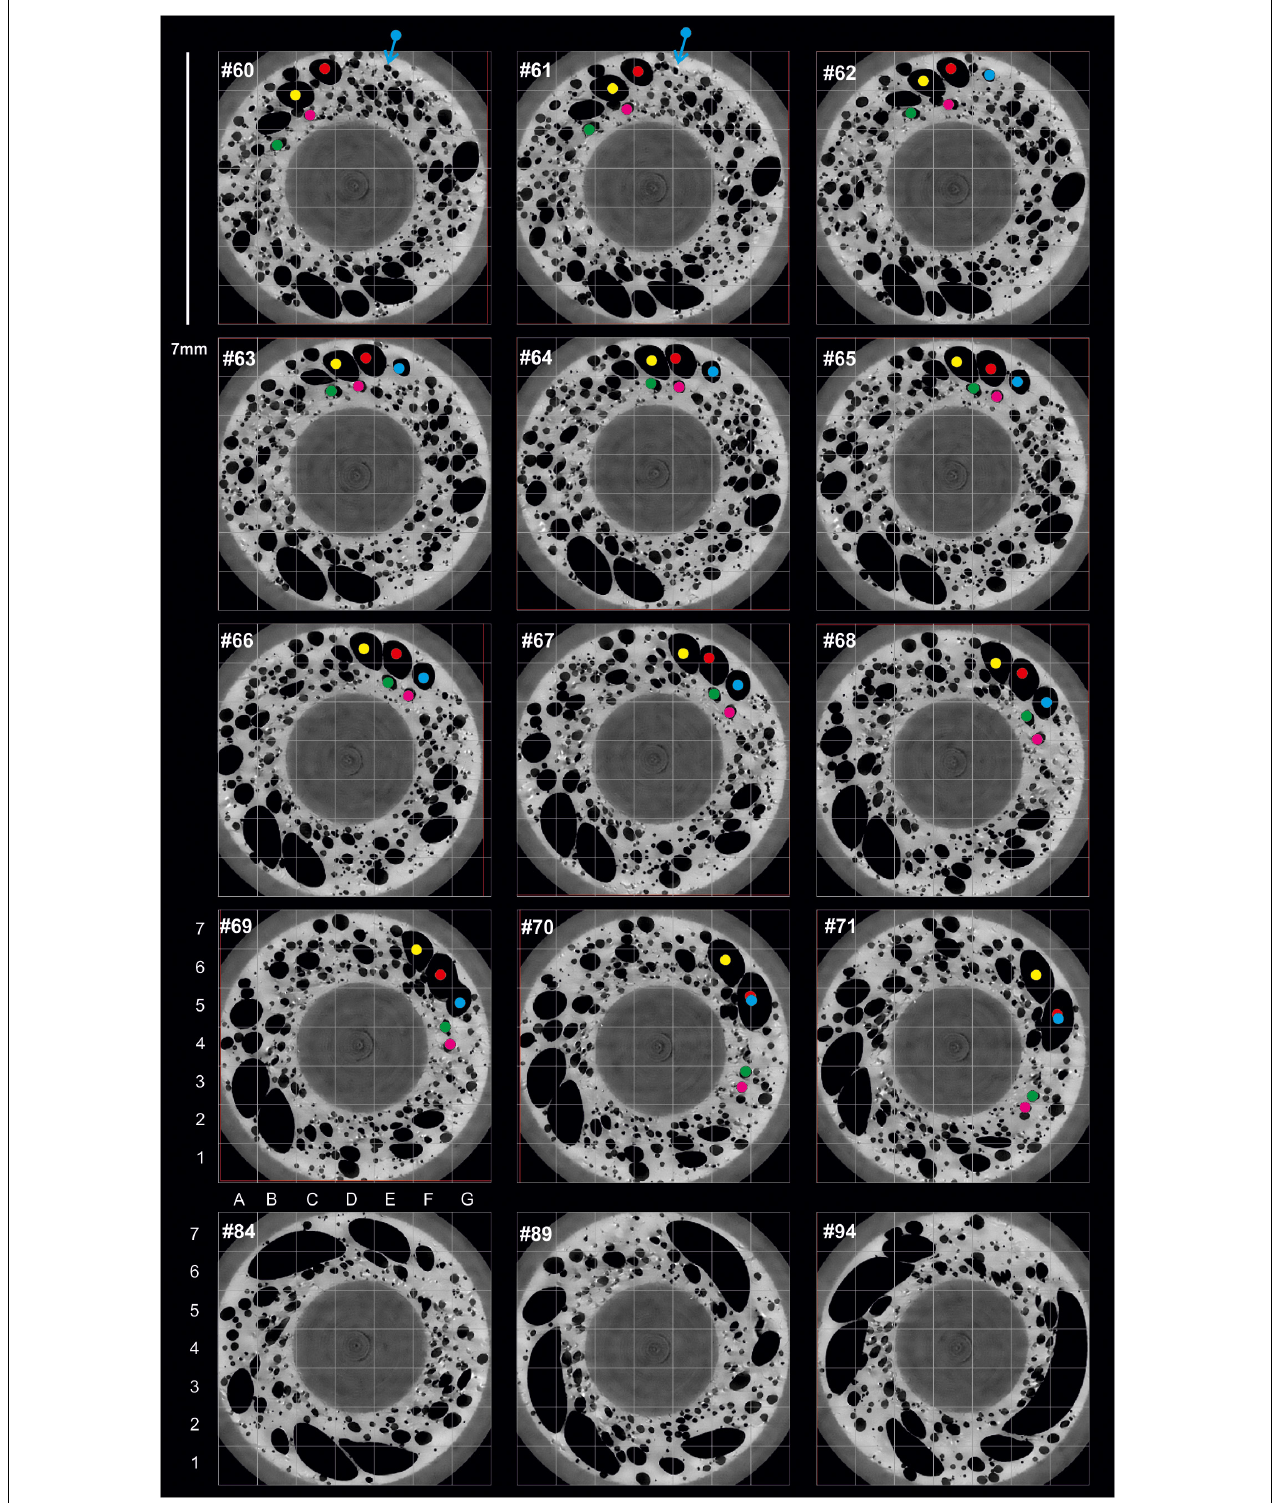
FIGURE 7 | Two-dimensional grayscale slices perpendicular to the rotation axis showing the deformation and coalescence in the mid slice tomographies between #60 and 94 during the end of acceleration and the start of steady state deformation at 0.3 rpm (#80 onward). Five bubbles are highlighted (red, yellow, blue, green, pink) see text for details. Note that the bottom row shows every 5th tomography over the initial part of the constant deformation.